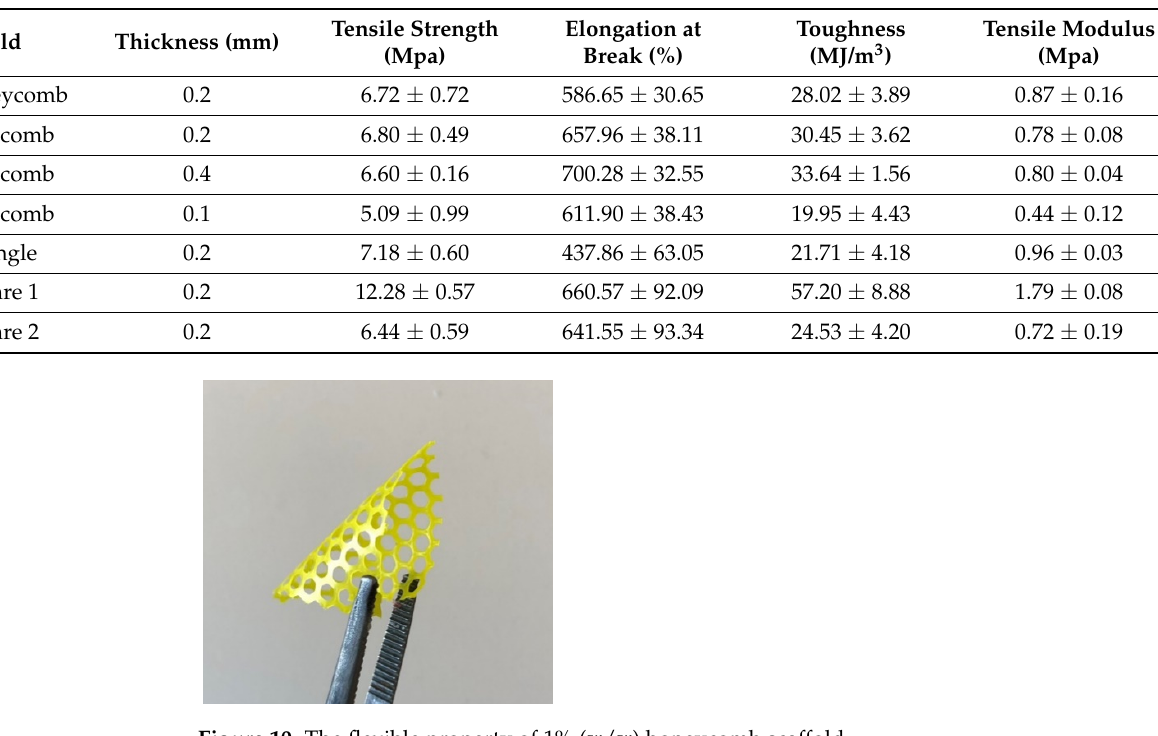
Figure 10. The flexible property of 1% ( w / w ) honeycomb scaffold.